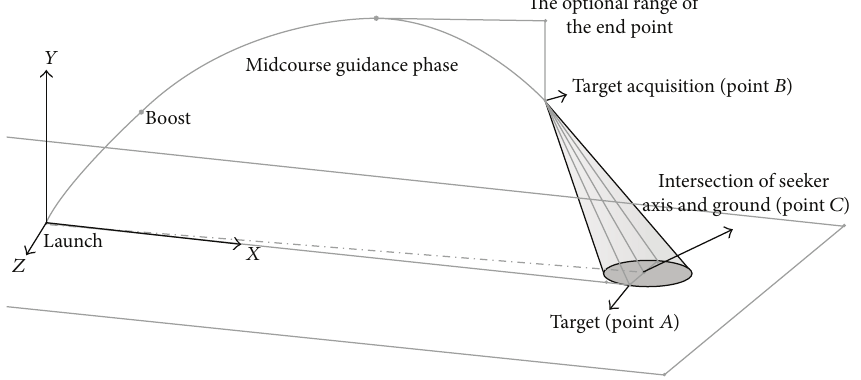
Figure 1: Phases of